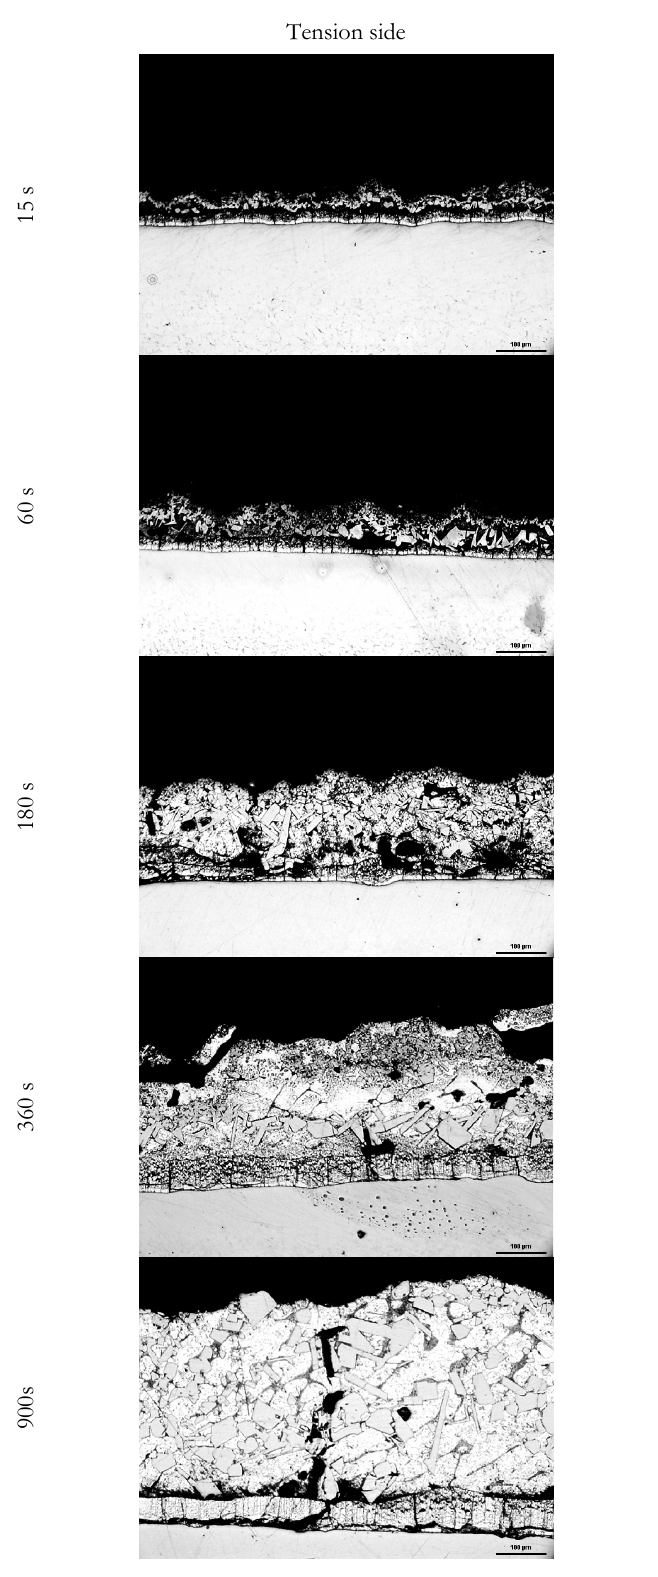
Figure 6: LOM analysis of intermetallic phases damage in Zn-Ti